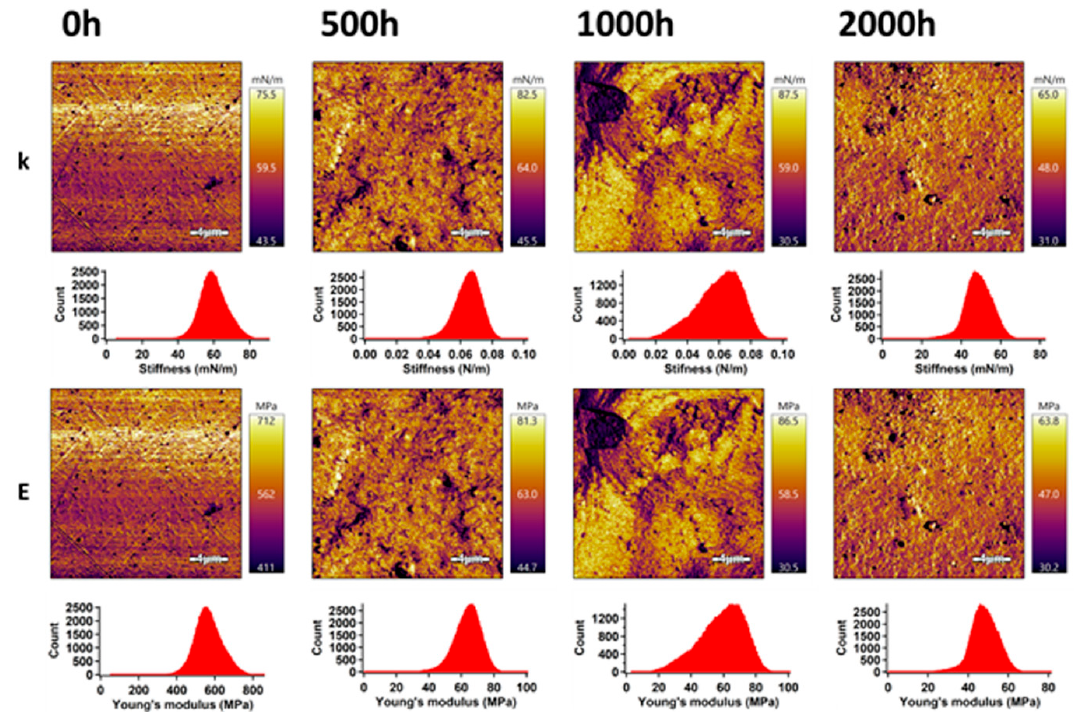
Figure 4. AM–FM images and histograms of PLA/TiO 2 samples before and after accelerated weathering; k and E represent stiffness and Young’s modulus, respectively.